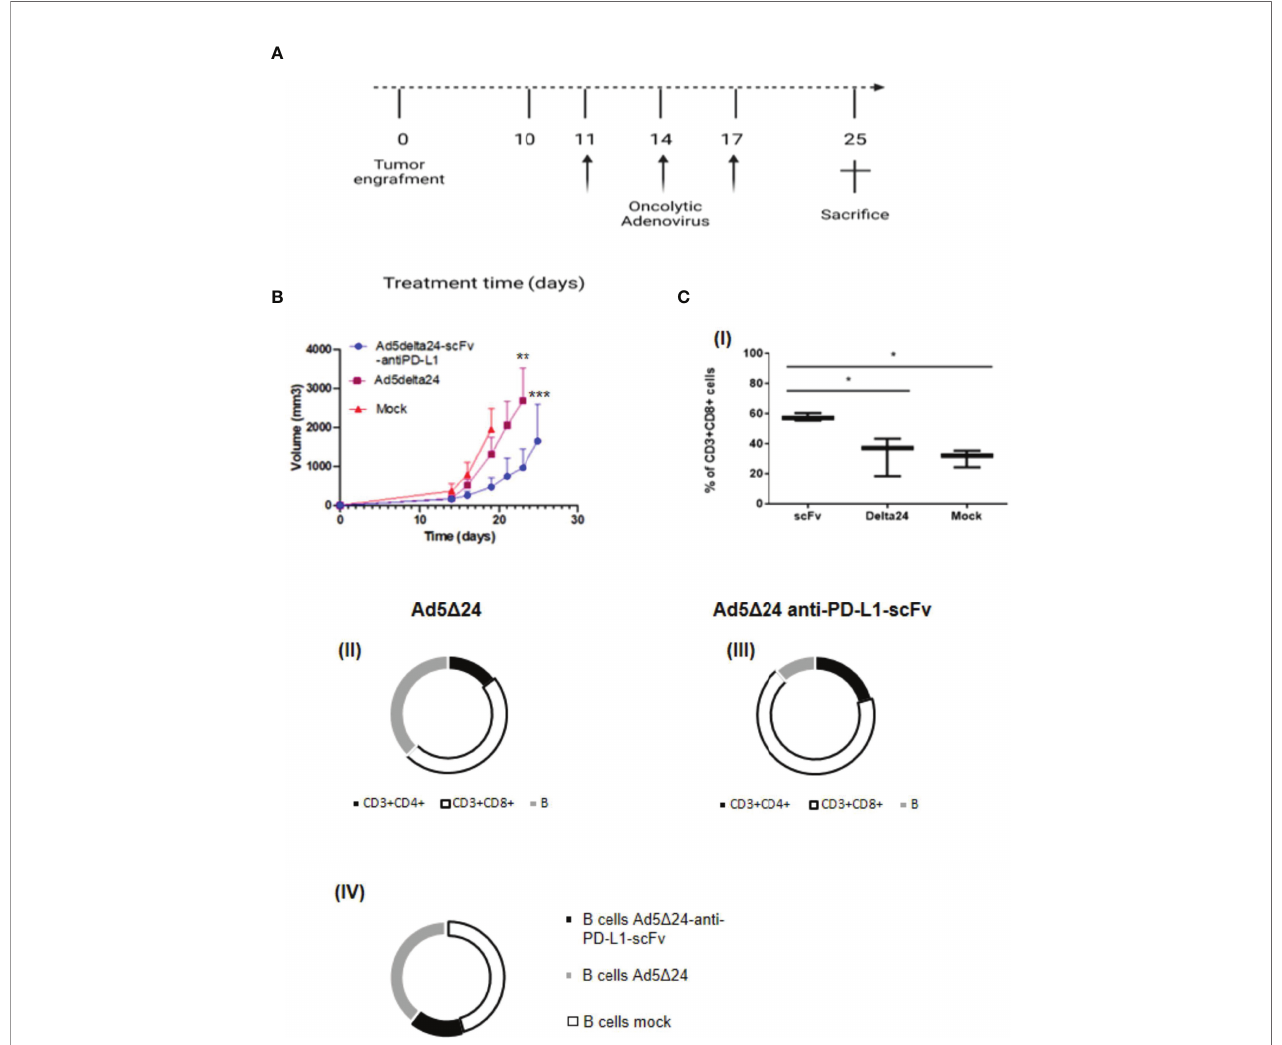
FIGURE 4 | Effect of Ad5 D 24-anti-PD-L1-scFv infection in melanoma mouse model. (A) Timeframe of the in vivo experiment. Five to six animals per group received subcutaneous B16.OVA melanoma cells (day 0) that were left to grow for 10 days. Then, 2 × 10E10 vp/kg mice of Ad5 D 24 or Ad5 D 24-anti-PD-L1-scFv or PBS were injected intratumorally. The intratumoral injection is repeated at days 11, 14, and 17 while at day 25 mice were sacri fi ced and tumors were collected. (B) Analysis of tumor size described in panel (A) . Tumors volumes were analyzed for each experimental group every 2 – 3 days until the day of sacri fi ce. The data are plotted as the mean ± SEM. The statistical analysis was performed with GraphPad Prism 5.02 version via Spearman test, with a p-value of 0.0028 for Ad5delta24 and 0.0004 for Ad5delta24-scFv-anti-PD-L1. (C) Percentage of CD3 + CD8 + tumor-in fi ltrating lymphocytes by fl ow cytometric analysis are plotted by Tukey box and whiskers for each group of animals (I). Statistical analysis was done by two-way ANOVA with a p-value of 0.0134. Flow cytometric analysis of CD3 + CD4 + , CD3 + CD8 + , and B220 + cells in tumor samples from each group of mice (II – III – IV). * ≤ 0.05, ** ≤ 0.01 and *** ≤ 0.001.